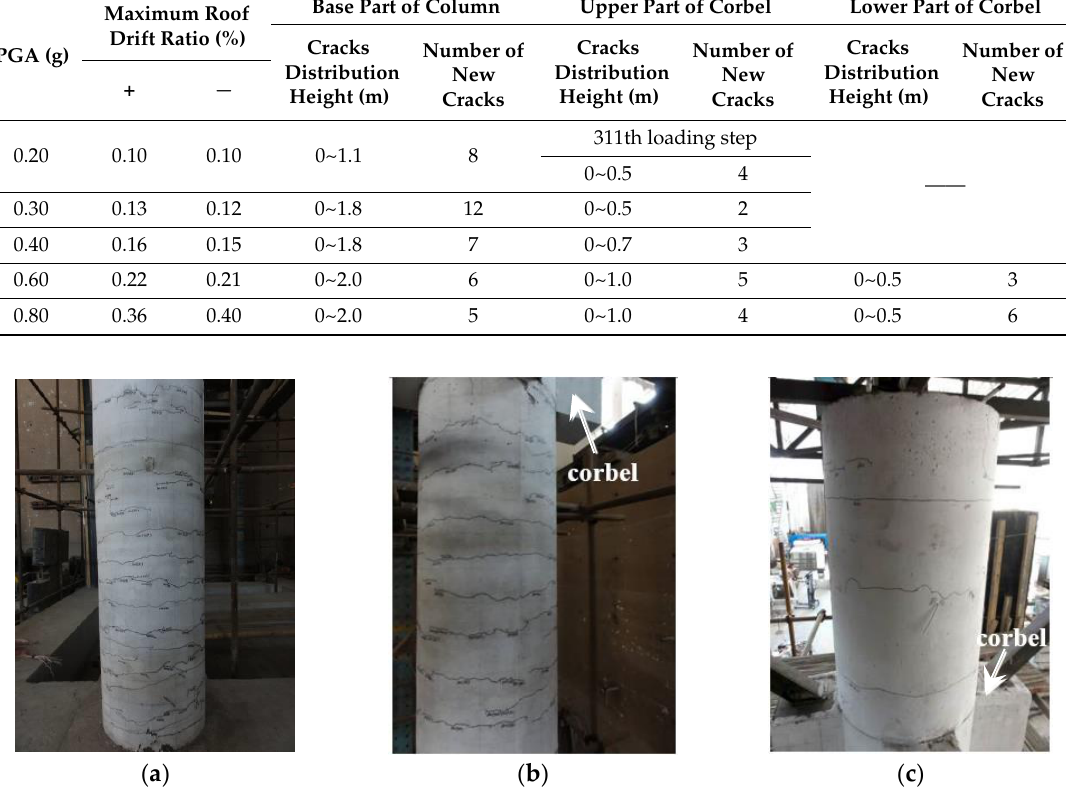
Figure 9. Observed cracking patterns of tubular columns at the end of PDTs: ( a ) Bottom of column; ( b ) Lower part of corbel; ( c ) Upper part of corbel.